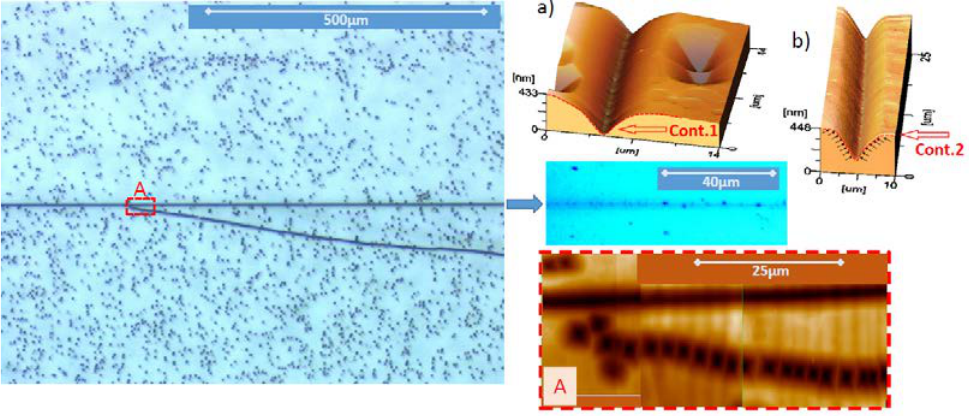
Figure 16. Distribution of etch pits for the 24.6° bicrystalline boundary in SrTiO 3 crystal shows similar irregularity than for the boundary 36.8°, namely a broad band of etch pits along of the boundary and their bundling (see magnification of region A). The shape of the “canyon” (see contours 1 and 2) of etch pits accumulated along of the boundary ( a , b ) suggests the existence of a hierarchical network (see discussion about etch pits for SrTiO 3 crystal given above in Figure 10). Probably the stress which accompanies the synthesis of the bicrystals is responsible for the increase of the mosaicity in both parts of the crystal and has generated a new boundary.